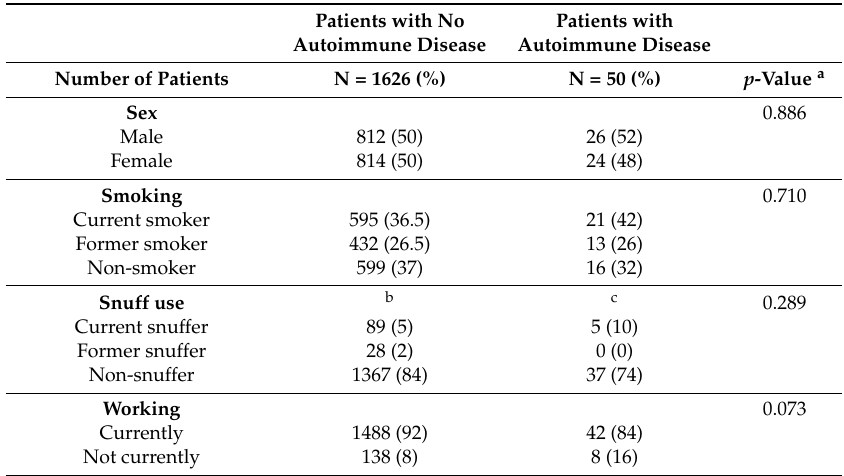
Table 1. Characteristics and health habits of patients without and with autoimmune